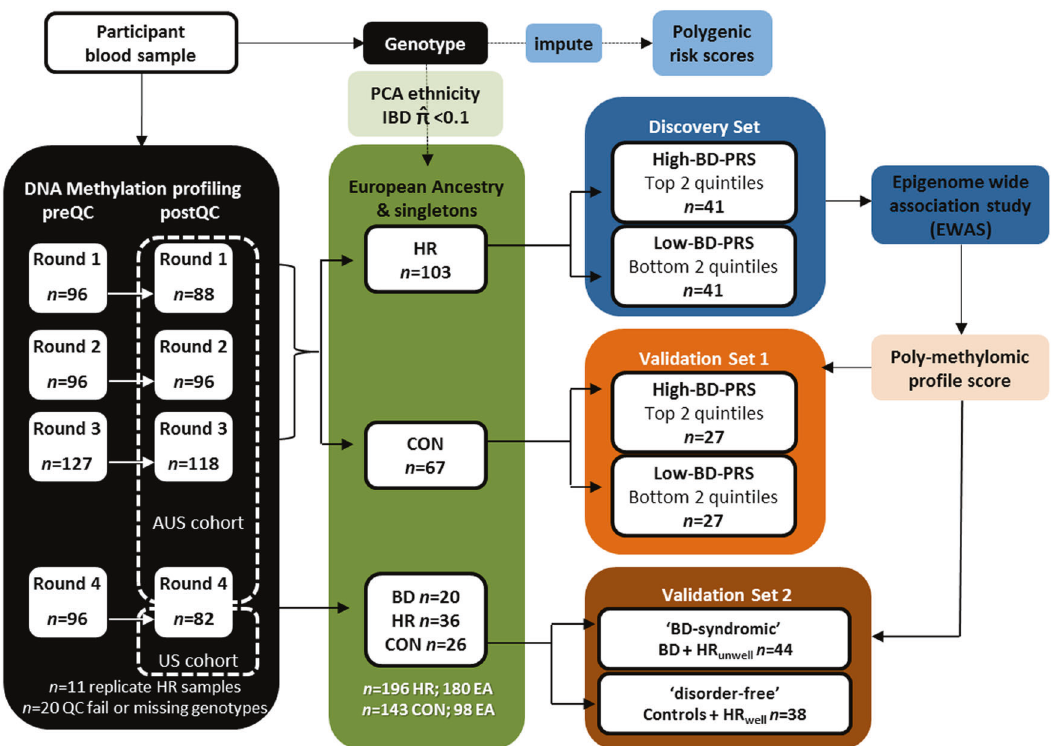
Fig. 1 Schematic overview of methods and the derivation of discovery and validation samples. PRS polygenic risk score, PMPS poly- methylomic pro fi le score, HR high-risk individuals, CON control, BD bipolar disorder, HR unwell high-risk individuals who developed sub- threshold or threshold BD at baseline or follow-up, HR well high-risk individuals who remained well after follow-up, EA European ancestry based on components from multidimensional scaling analysis of SNP genotype